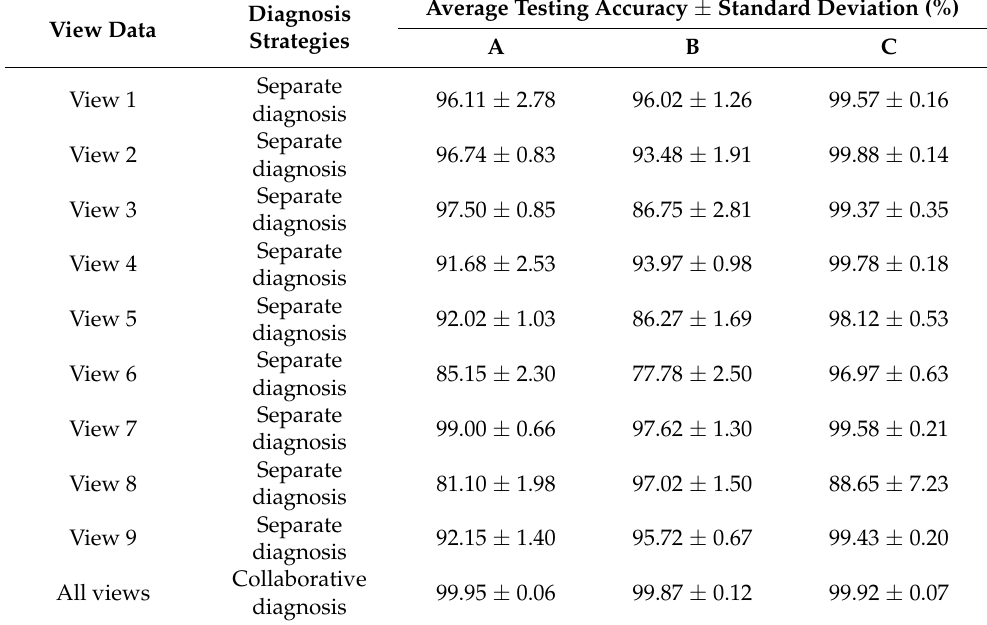
Table 4. Average testing accuracy, standard deviation, and model training average time of single- channel CNN data and